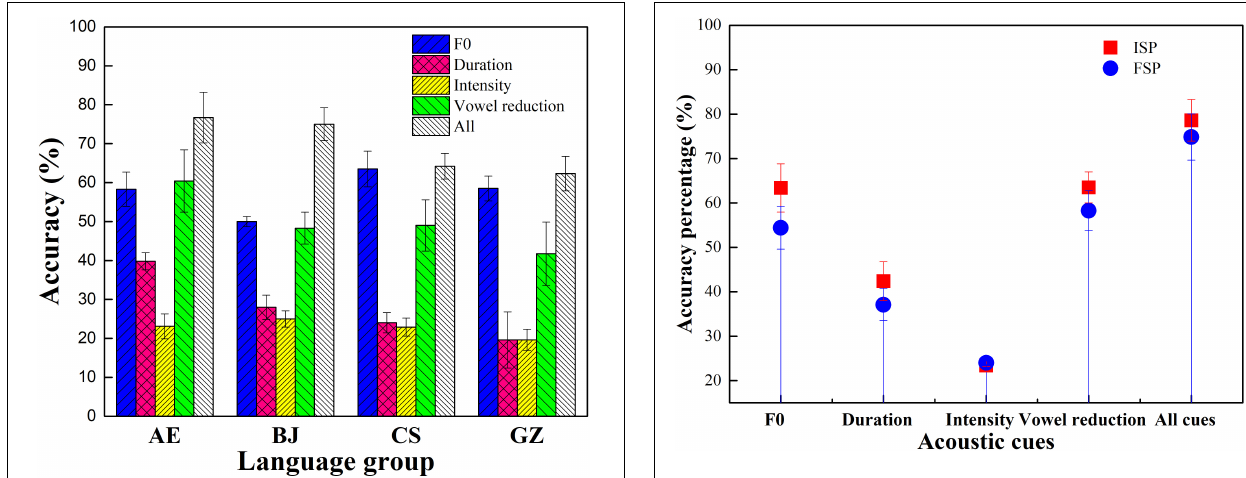
FIGURE 4 | Accuracy for Initial Stress Percentage (ISP) and Final Stress Percentage (FSP) with the American English (AE) group.